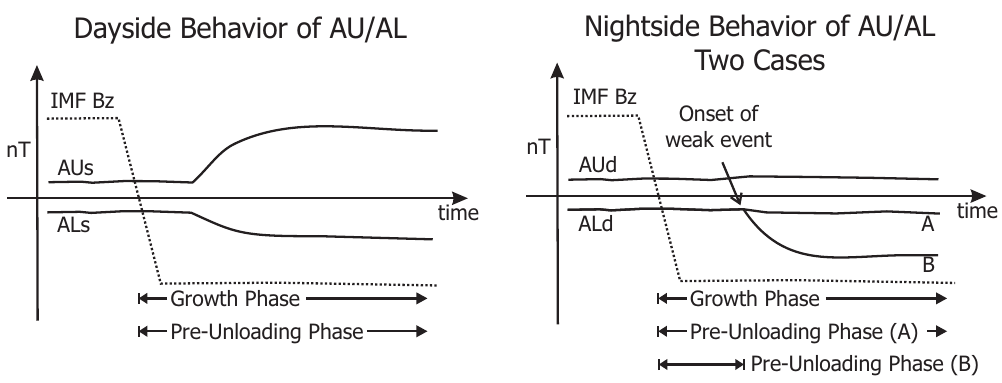
Fig. 12. Schematic summary figure showing the behavior of ALd for two different cases. Case A: An isolated substorm; and Case B: A weak event (e.g., a pseudo onset) preceding the substorm onset. For Case A both the growth phase and the “pre-unloading phase” end at the substorm onset. For Case B the “pre-unloading phase” ends at the onset of the weak event while the growth phase ends at the substorm onset.